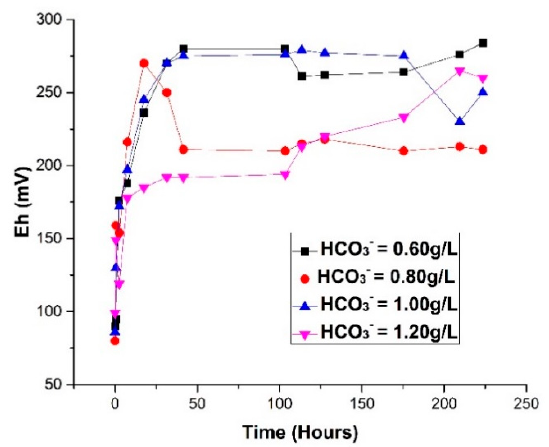
Figure 11. Change in Eh measurements in the leaching solution with different HCO 3 − concentrations.